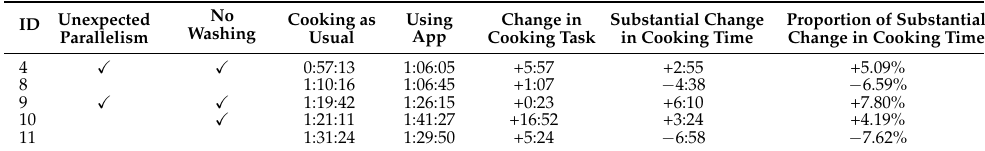
Table 6. Result of experiment for each user (Group B).